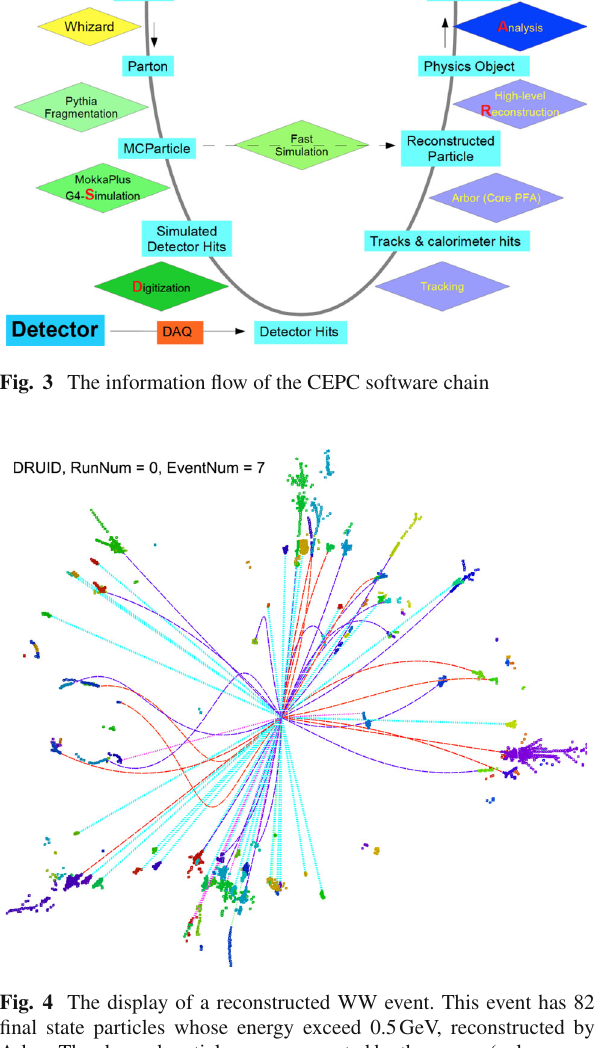
Table 2 The values of σ B for different